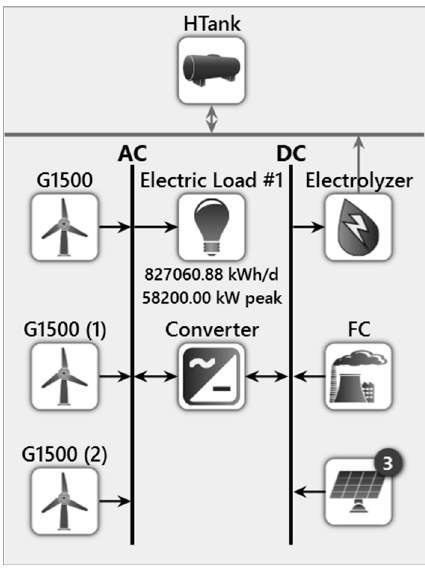
Figure 5. Schematic diagram of wind-PV-FC system.